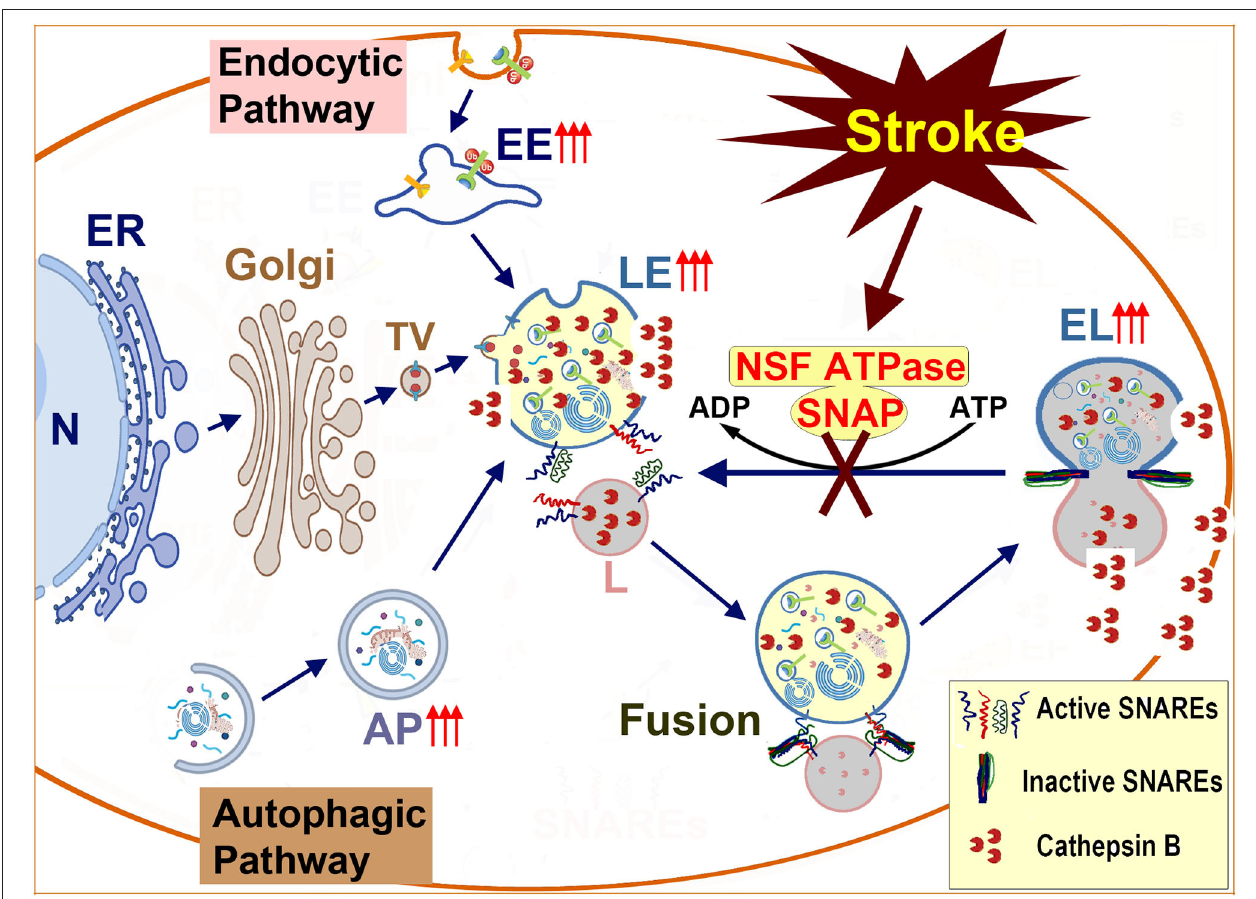
FIGURE 7 | Schematic diagram of endolysosomal trafficking after brain ischemia: endolysosomal hydrolytic enzymes, membrane components, and structural proteins are synthesized on the ER-associated polyribosomes, modified in the ER and the Golgi lumen, and transported to the late endosome. The late endosome also receives incoming cargos from the endocytic and autophagic pathways. The enzyme- and cargo-loaded late endosome fuses with the terminal lysosome to form an endolysosome to digest cargos. After, the endolysosome reform into a terminal lysosome for the next round of fusion. The membrane fusion is mediated by the NSF-SNAP-SNAREs machinery and assisted by other proteins such as HOPS complexes and Rab7. Brain ischemia inactivates NSF ATPase, prevents the regeneration of active SNAREs, and interrupts incoming traffic from both the autophagic and endocytic pathways. This interruption leads to a buildup of damaged LE and EL to release cathepsins such as CTSB and brain ischemia reperfusion injury. N, Nucleus; ER, Endoplasmic Reticulum; Golgi, Golgi apparatus; TV, Transport Vesicle; EE, Early Endosome; AP, Autophagosome; LE, Late Endosome; L, Lysosome; NSF, N-ethylmaleimide Sensitive Factor (ATPase); SNAP, Soluble NSF Attachment Protein; SNARE, SNAP